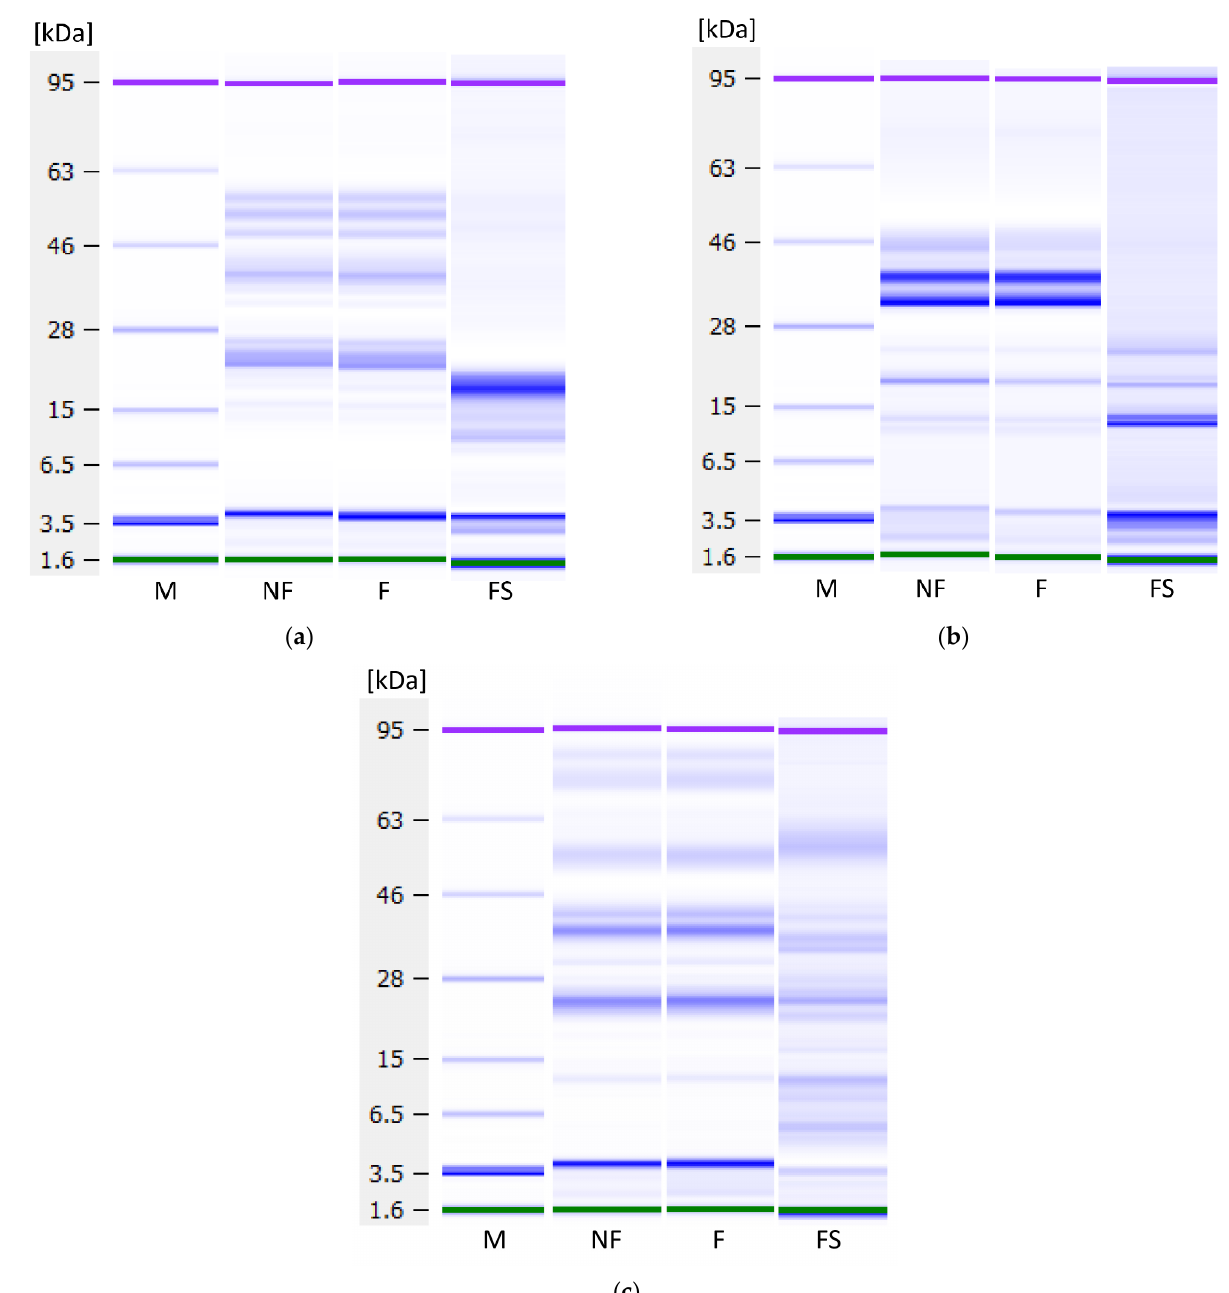
Figure 9. Protein profiles under reducing conditions as measured with the Agilent Bioanalyzer. ( a ) Lentil, ( b ) dairy and ( c ) soy samples. M—marker, NF—non-fermented samples, F—fermented samples, FS—fermented samples, soluble proteins. Green and purple bands are marker bands, and the bands at 3.5 kDa are system peaks that do not derive from the samples.